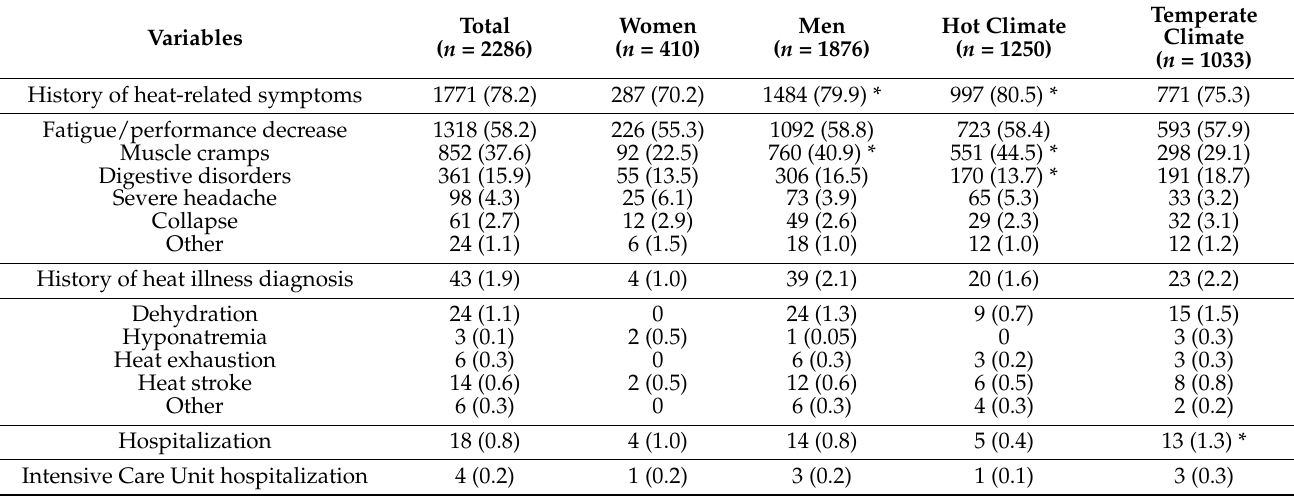
Table 2. Previous history of symptoms and diagnosis of heat illness in the Grand Raid de la R é union runners by total sample and according to sex and climate of residence.